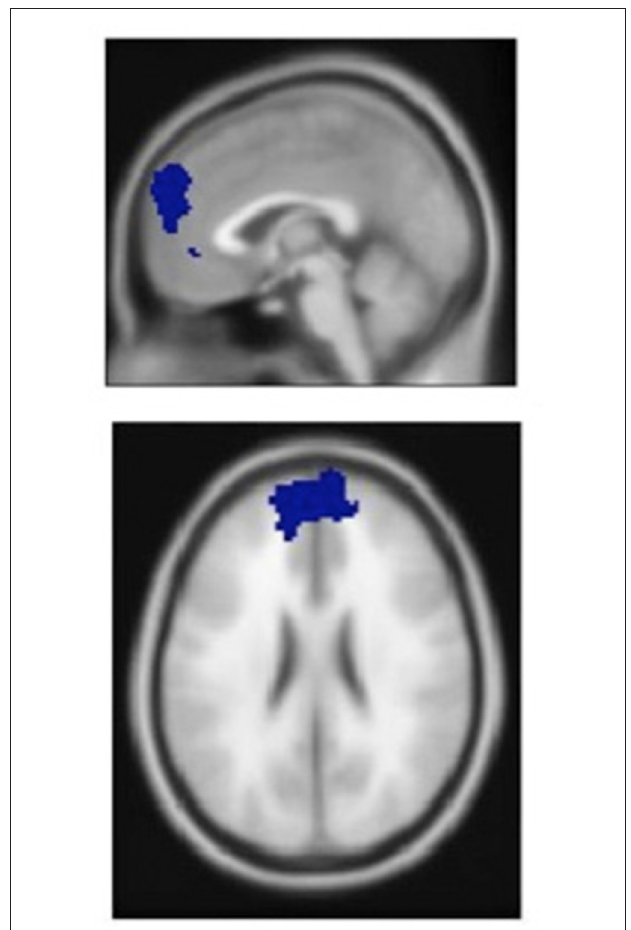
FIGURE 1 | Medial prefrontal cortex (mPFC) area identified by general linear model (GLM) analysis of neural activation during music listening.